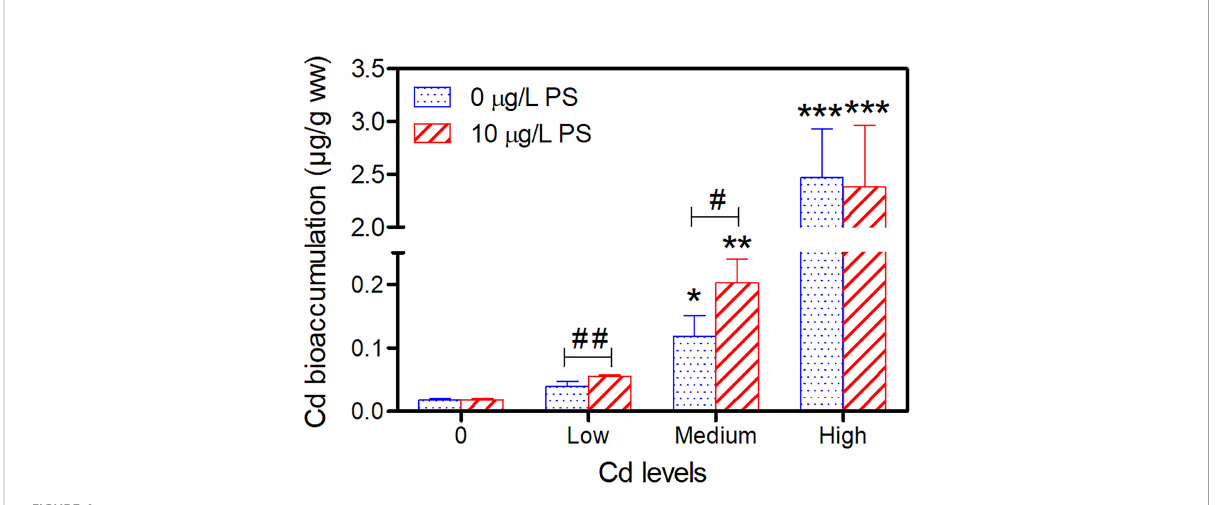
FIGURE 4 Cd bioaccumulation in P. aibuhitensis after 7 days of exposure to Cd alone and Cd combined with 10 m g/L of PS. Results are presented as means ± SD ( n = 4). Signi fi cant differences against controls are shown as *( p < 0.05), **( p < 0.05), and ***( p < 0.001), while differences between Cd and Cd + PS exposure are shown as # ( p < 0.05) and ## ( p < 0.01).